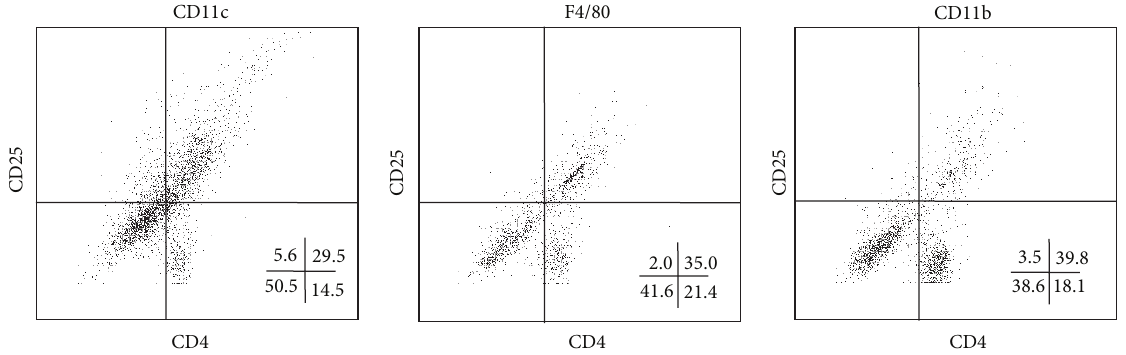
Figure 2: Representative dot-plots of flow cytometric analysis of an expression of CD25 molecules on OT-II CD4 + lymphocytes after coincubation with CD11c + , F4/80 + , and CD11b + spleen cells isolated from pregnant